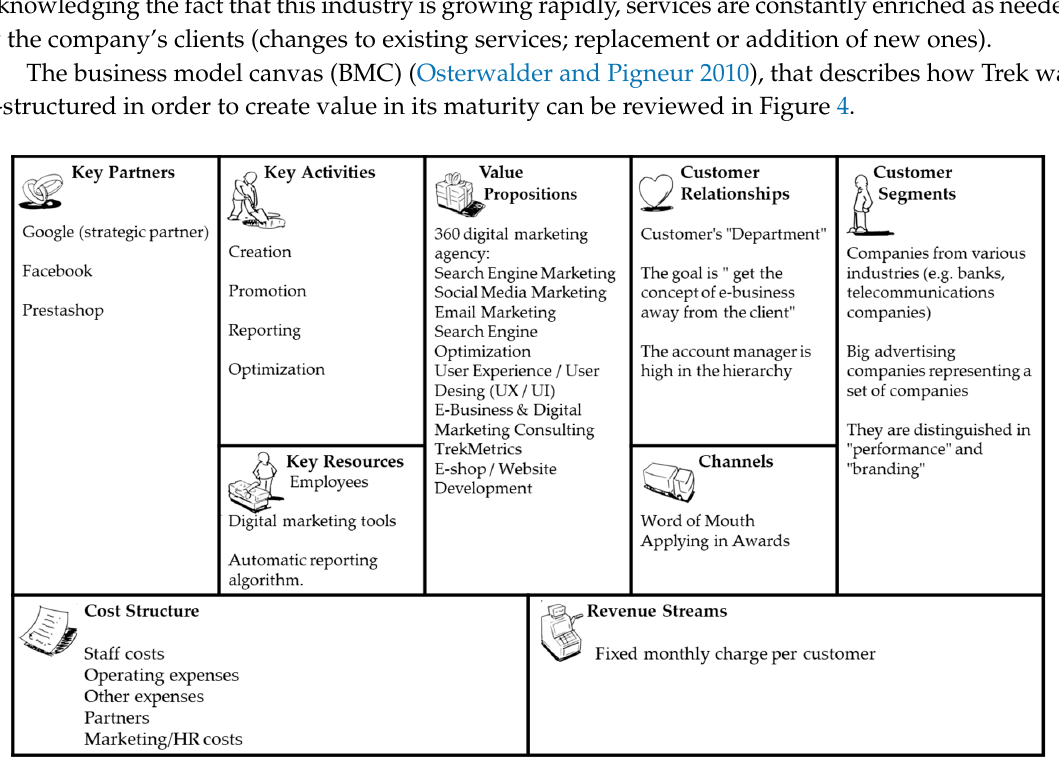
Figure 4. Trek’s Business Model Canvas in its Maturity Stage. Adapted from (Osterwalder and Pigneur